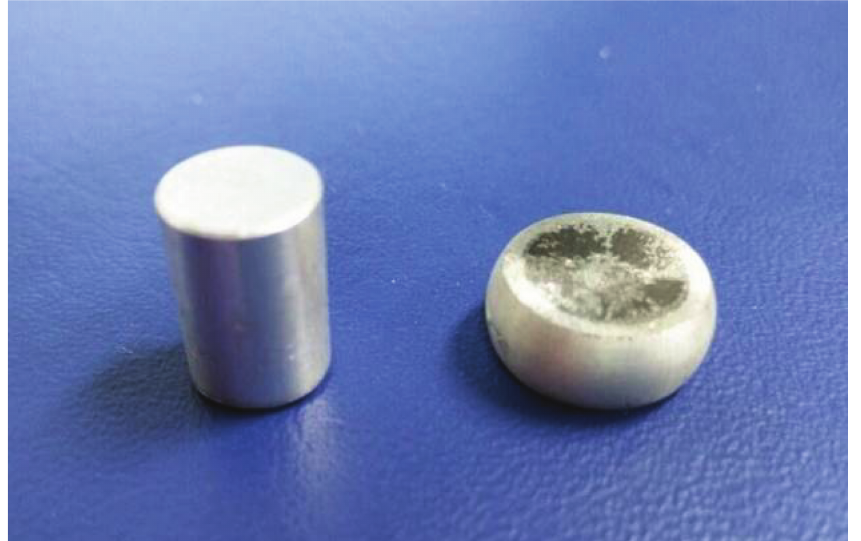
Figure 3: The original sample and iso- thermal compression samples.